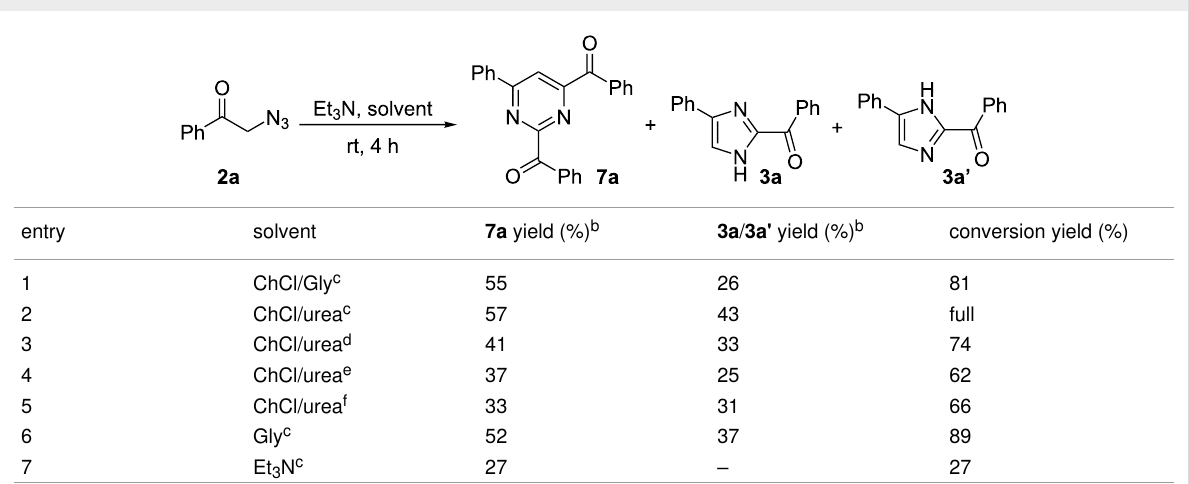
Table 2: Investigation of the reaction conditions in the synthesis of 7a .